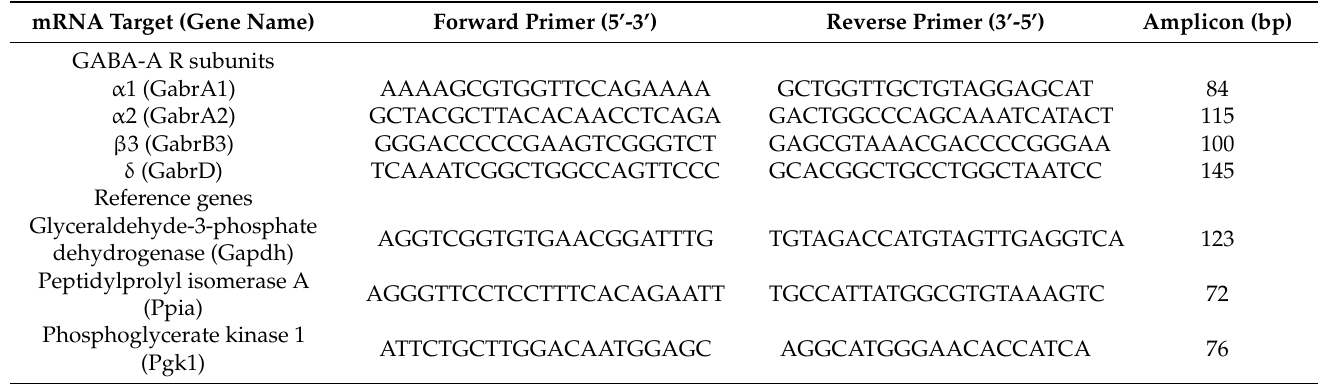
Table 1. Sequences of the oligonucleotides used for real-time PCR amplification. mRNA Target (Gene